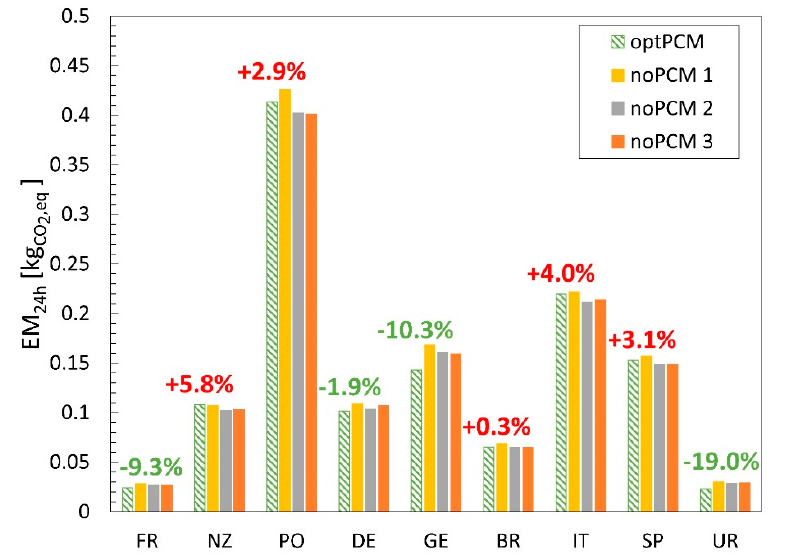
Figure 5. Comparison of carbon emission of the refrigerator with and without Phase Change Materials (PCMs) among different case studies with the initial condition equal to 0 (the first starting time of the refrigerator in the optimization procedure was fixed at 0). The percentage values above each bar represent the difference between the optimal hysteresis scheduling, optimizing daily carbon emission. The minimum daily carbon emission obtained simulates the refrigerator without PCM with a fixed hysteresis.